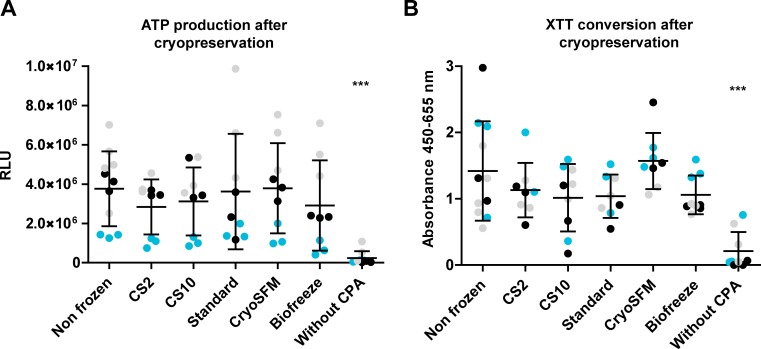
No change in metabolic activity in synovial explants after thawing.ATP and XTT levels were determined in triplo in OA synovial tissue of 3 patients. Patient 4: blue dots, patient 5: black dots, patient 1: grey dots. (A) Shown are the relative light units (RLU) (B) Shown is the percentage increase in absorbance over a 4 hour period, depicted as the mean +/- the SD. Statistical analysis was performed by one-way ANOVA, comparing the non-frozen control to the cryopreserved conditions. *** p<0.001.